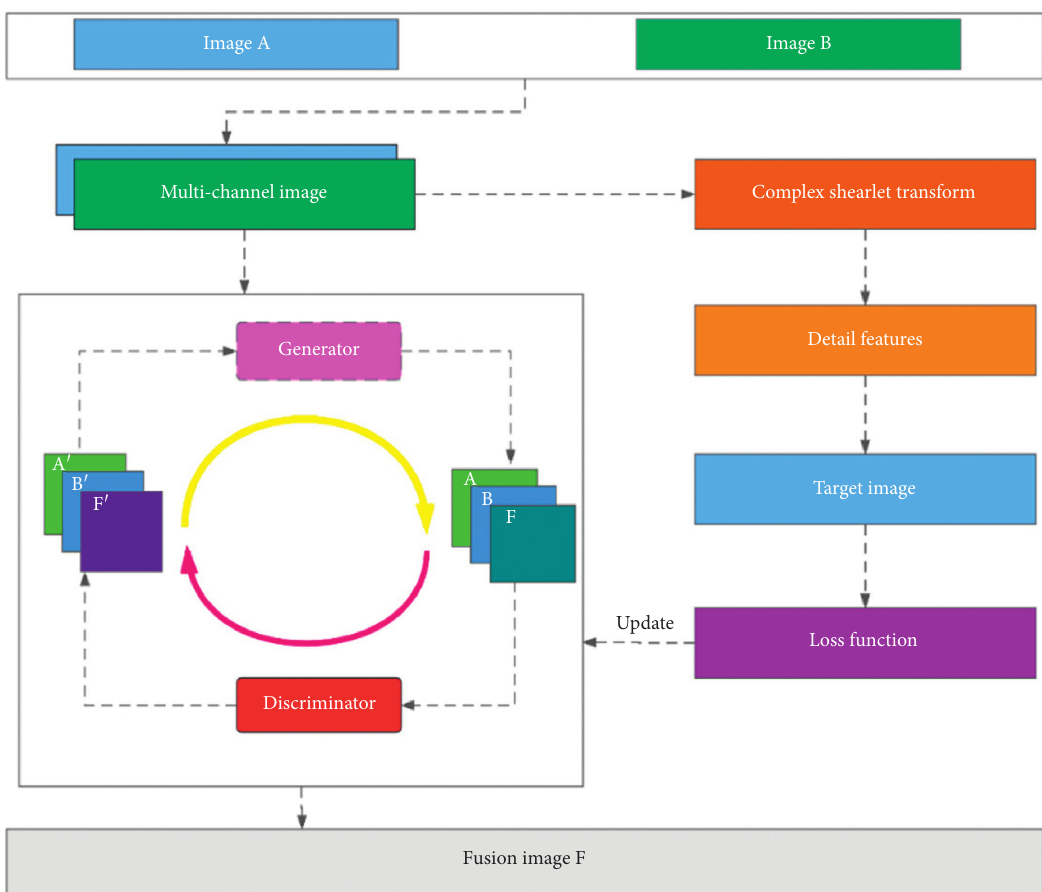
Figure 1: The architecture of the proposed